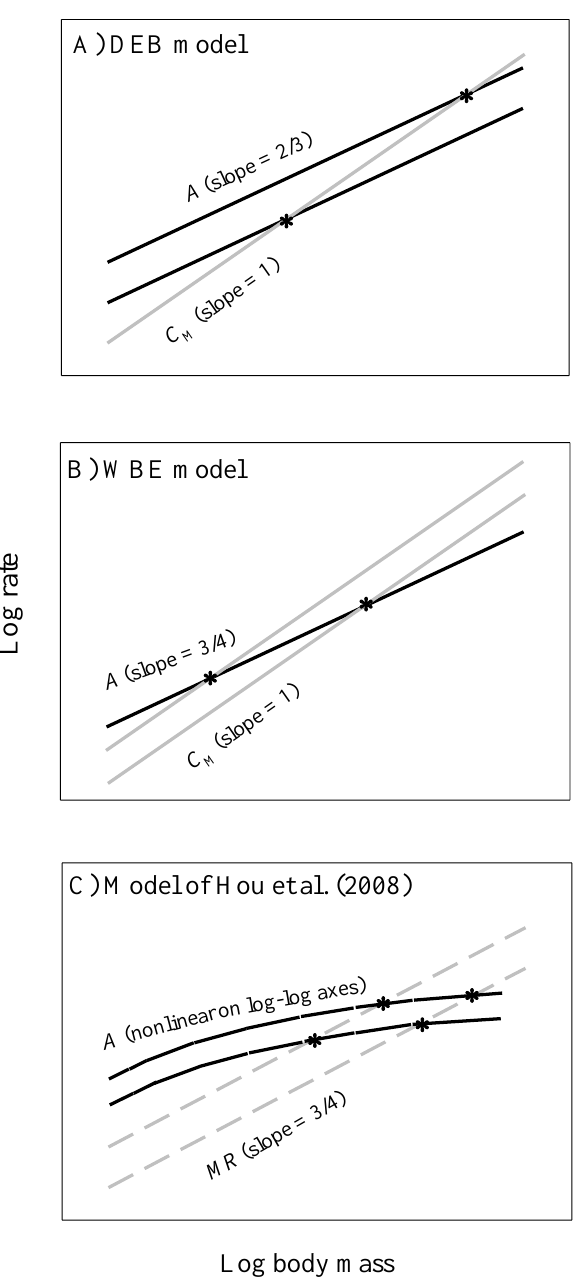
Figure 10. Schematic diagrams illustrating predictions of maximal adult body mass or volume (indicated by black dots) based on three growth models. In ( A , B ), the maximal body mass or volume is predicted to occur at the intersection of the scaling relationships for the rates of food-energy assimilation ( A , red lines) and energy expenditure for body maintenance (C M or C V scaled to body mass and structural volume, respectively, as indicated by blue lines). Different maximal body masses are predicted based on variation in the elevation of the scaling relationship for A (following the DEB model of [96,97]) or C M (following the WBE model of [98]). The DEB and WBE models also differ in positing that A should scale to the 2 / 3-versus 3 / 4-power, respectively. In ( C ), the maximal body mass is predicted to occur at the intersection of the scaling relationships for A and total metabolic rate ( MR , green lines). According to the model of [147], A scales curvilinearly with body mass, whereas MR scales linearly to the 3 / 4-power. Different maximal body masses are predicted based on variation in the elevation of the scaling relationships for either A or MR . DEB: dynamic energy budget theory; WBE: West, Brown and